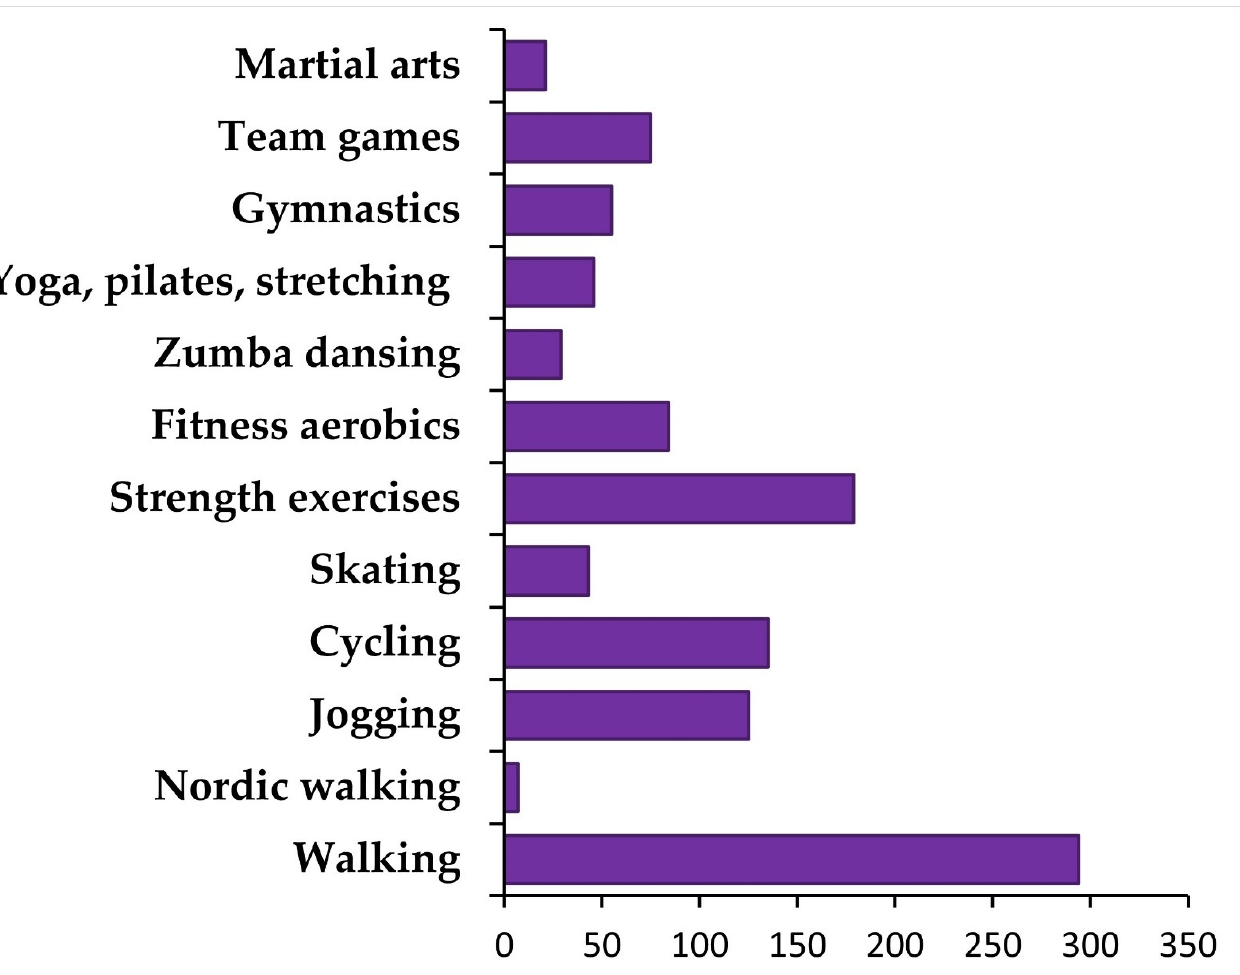
Figure 1. Number of university students engaging in different physical activities ( N = 473).